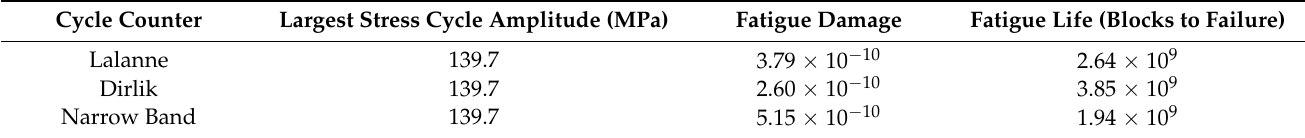
Table 7. Fatigue life results for the solid blade.